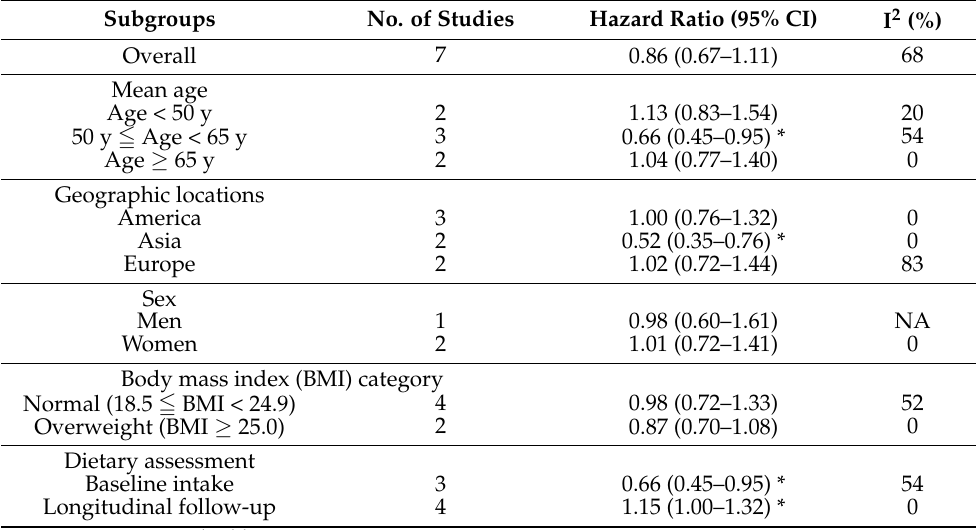
Table 2. Subgroup